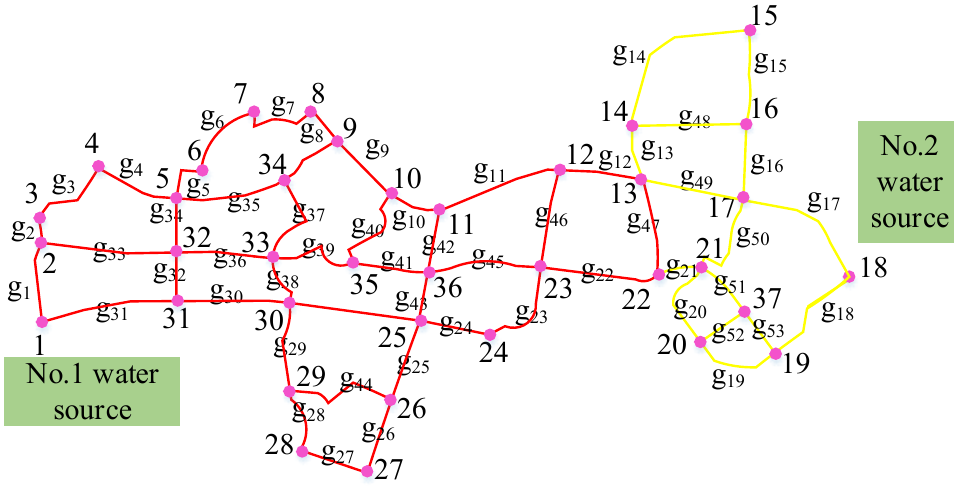
Figure 4. Schematic diagram of water supply network in a town.